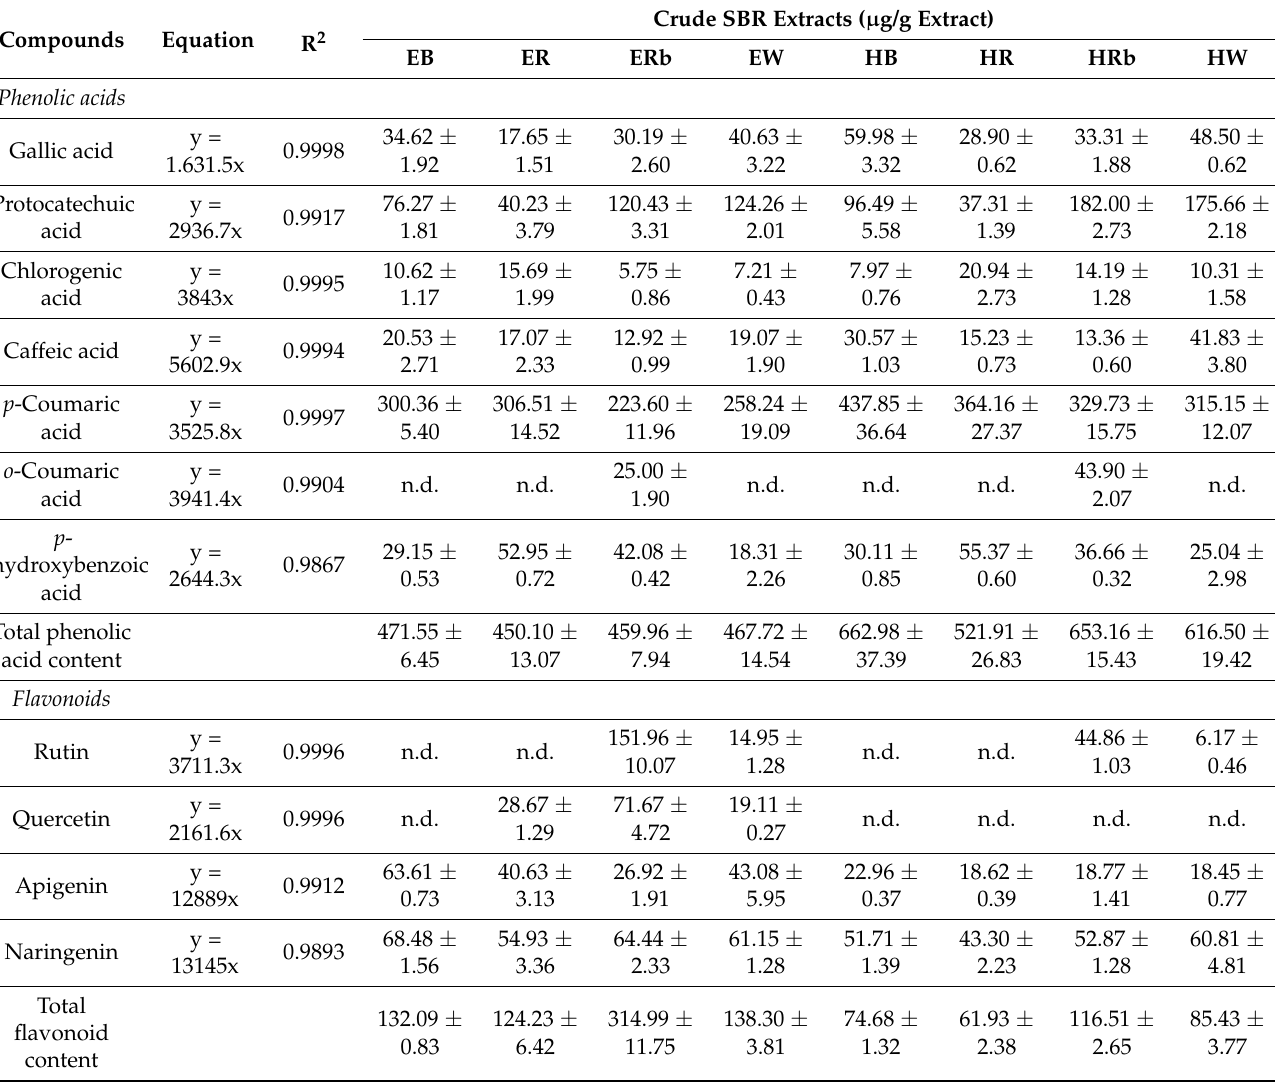
Table 6. Phenolic compounds identified from 50% ( v / v ) ethanol and hot water extracts of SBR using LC–ESI-QqQ- MS/MS